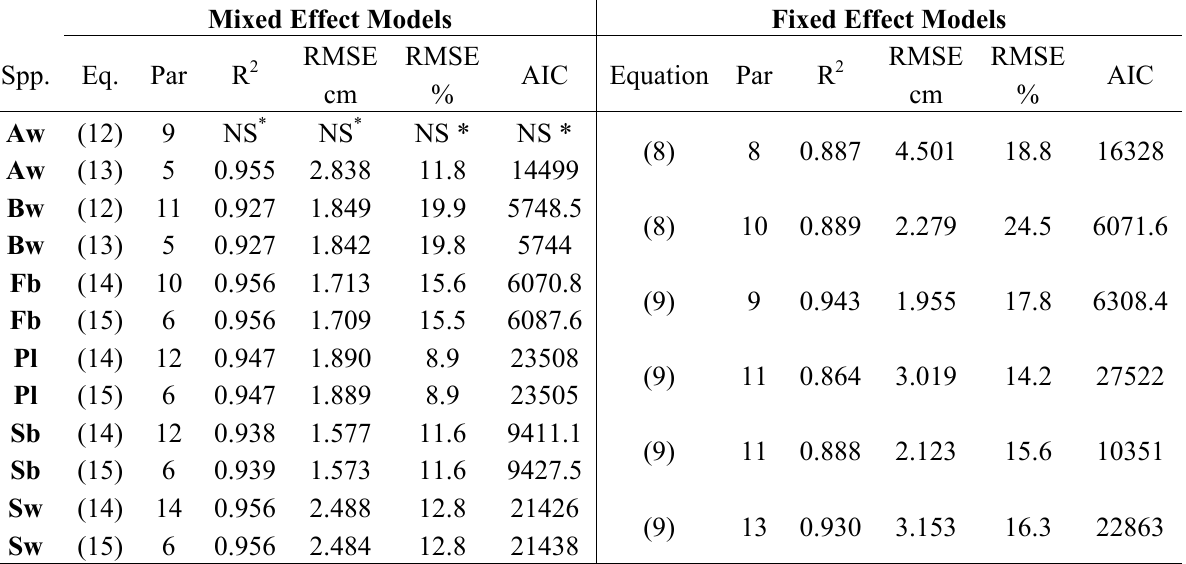
Table 8. Goodness-of-fit of mixed effect models (plot as the random subject) for tree diameter modeled as a function of height, crown area, basal area of the larger trees and natural sub-regions ( i.e. , Equations (12) and (14)), or without natural sub-regions ( i.e. , Equations (13) and (15)). For trembling aspen and white birch, Equations (12) and (13); and for balsam fir, lodgepole pine, black spruce and white spruce, Equations (14) and (15), as described in Section 2.4. Goodness-of-fit of fixed effects models, Equations (8) and (9), are also presented for comparison purposes.